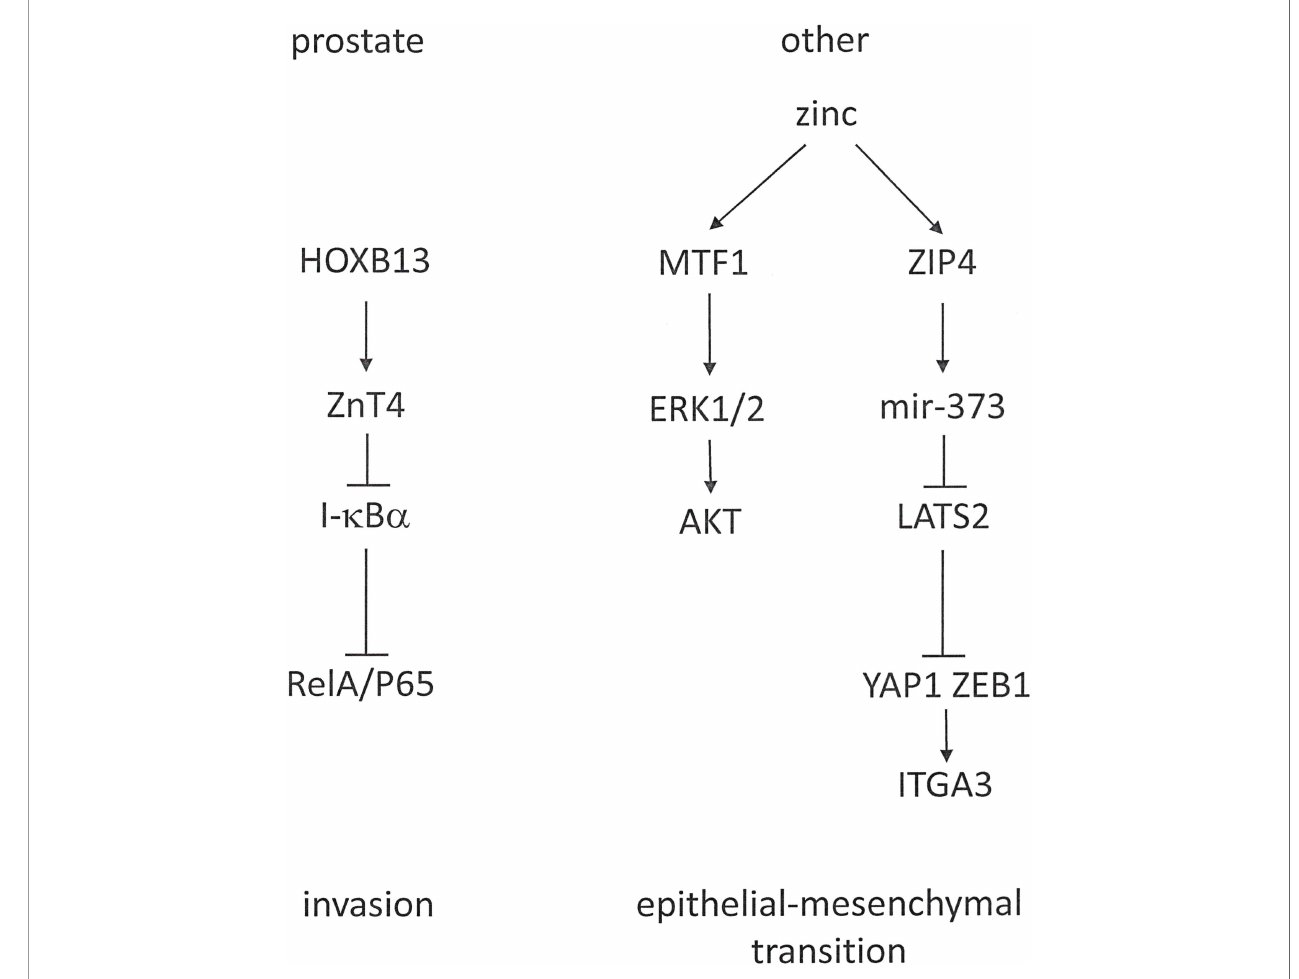
FIGURE 6 | Cancer-type-speci fi c roles for zinc in tumor progression. Zinc metabolism has a different role in prostate cancer, where it is reduced (left), compared to other malignancies, which increase zinc utilization